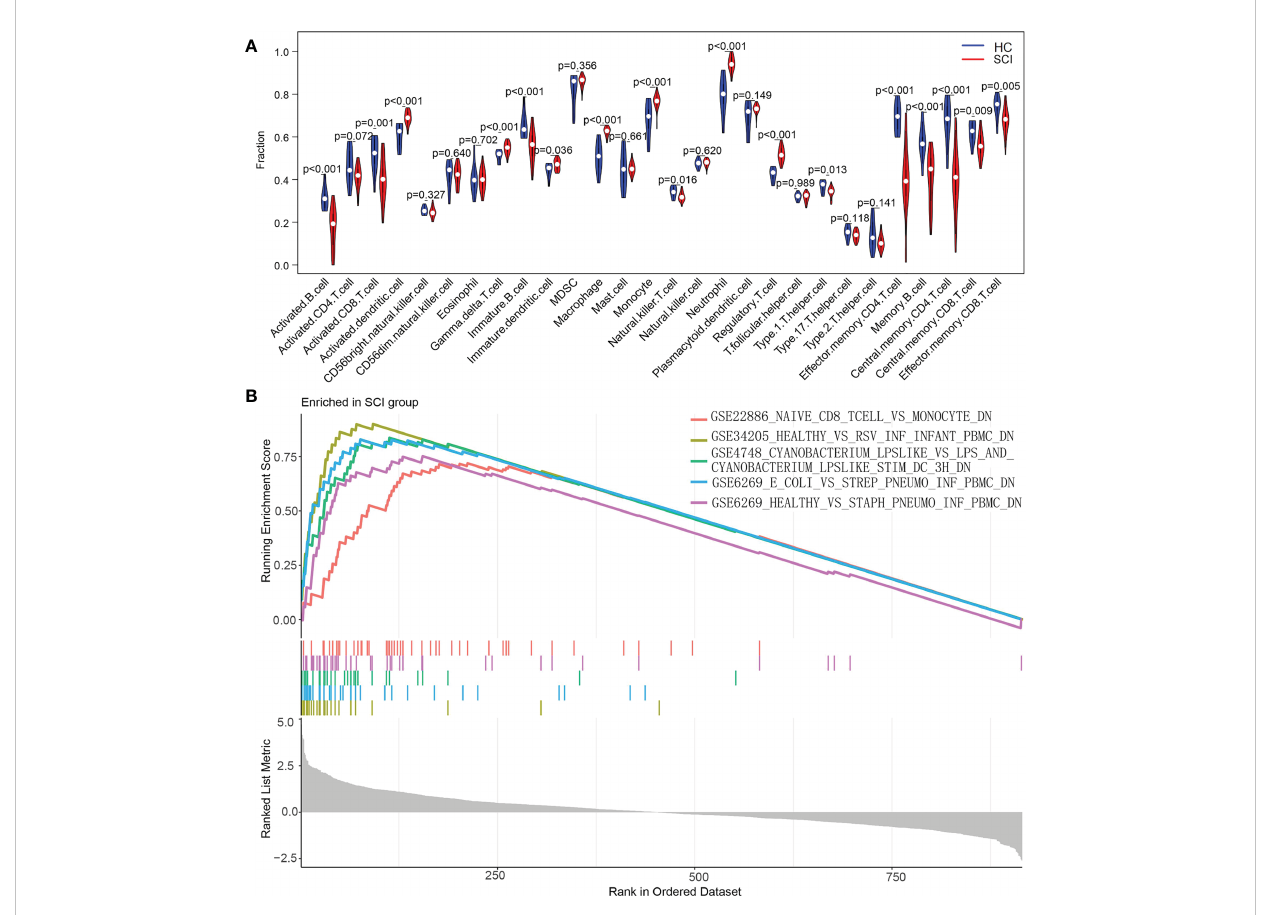
FIGURE 9 Analysis of the immune landscape associated with SCI. (A) Violin plot of differences in the content of immune cells between the SCI and HC groups analyzed using the ssGSEA algorithm. (B) Enrichment map of the GSEA Immunologic Signature Database of the SCI group. SCI, spinal cord injury; HC, healthy uninjured control. ssGSEA, single-sample gene set enrichment analysis; GSEA, gene set enrichment analysis.